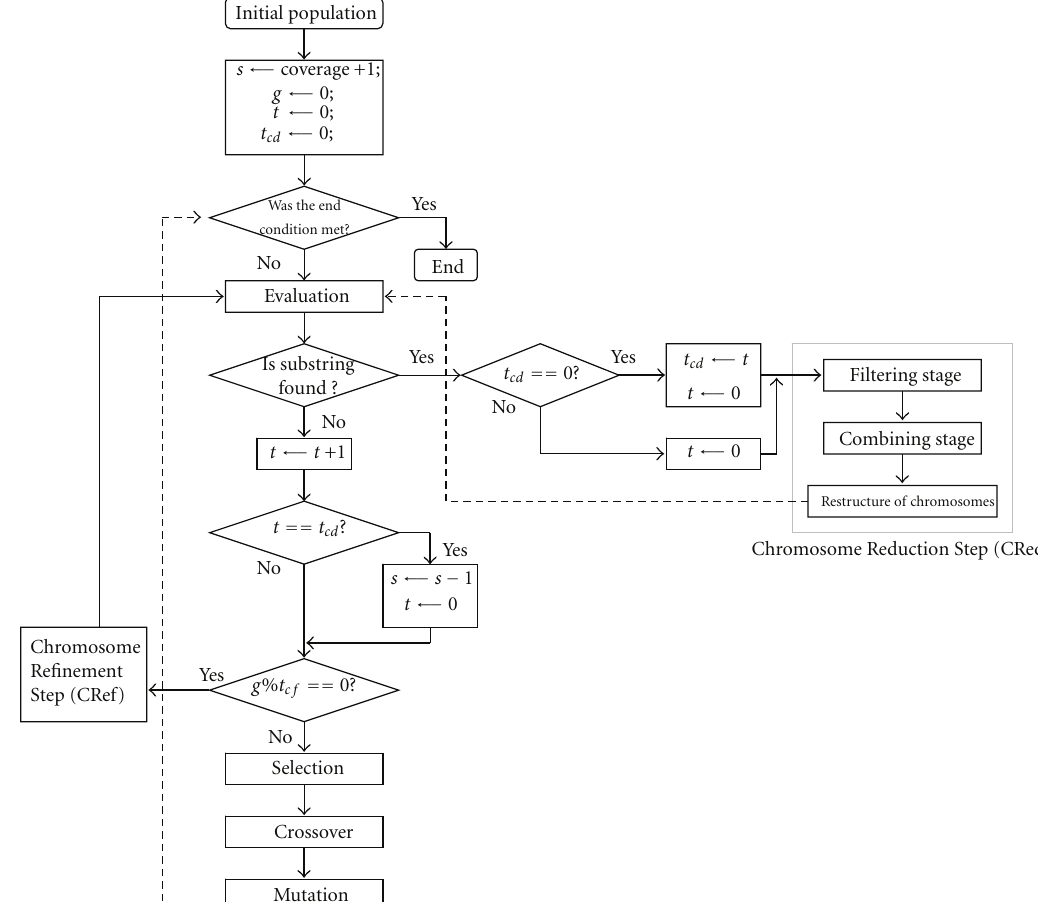
Figure 4: Algorithm including CRed and